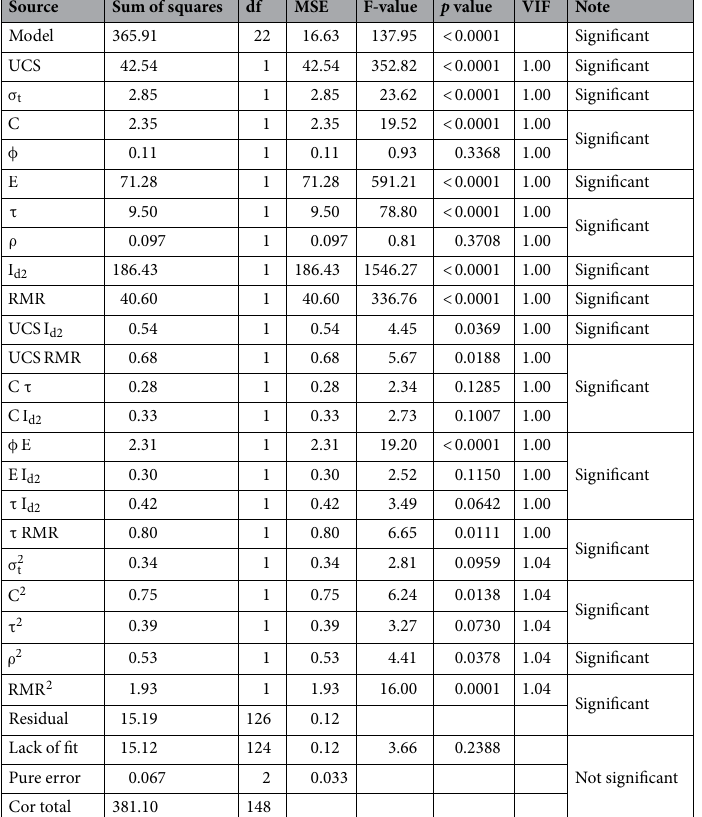
Table 5. Results of ANOVA for the proposed